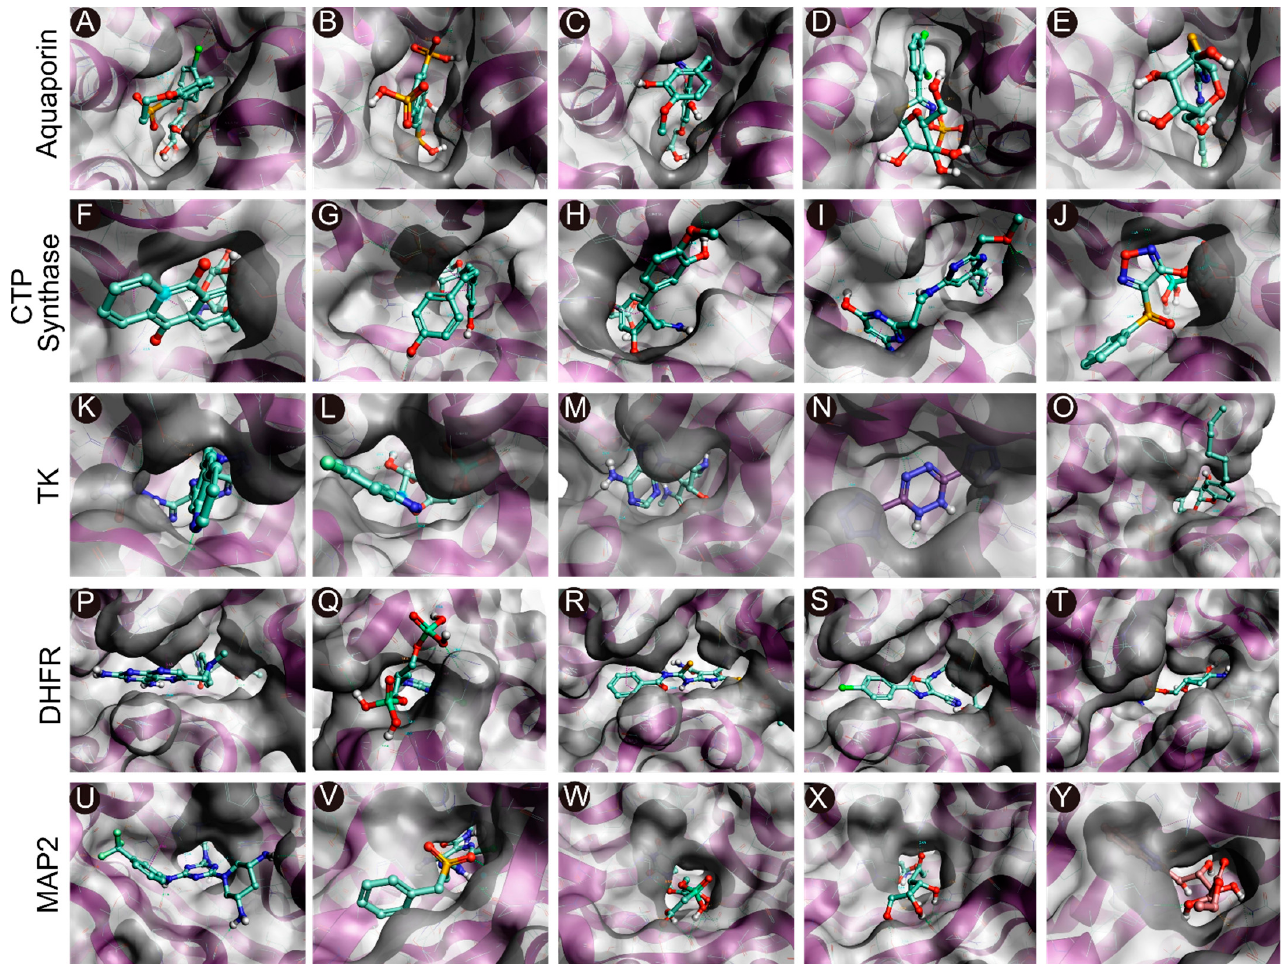
Figure 2. Molecular docking of the compounds to the predicted binding pockets of the five druggable protein targets of EHP. ( A – E ) Best binding poses of the five selected compounds atthe binding site of AQP (( A ): CHEMBL3703838; ( B ): ZINC000002243083; ( C ): CHEMBL133039; ( D ): CHEMBL3140193; and ( E ): CHEMBL2132563). ( F – J ) Best binding poses of the five selected compounds atthe binding site of CTP synthase (( F ): CHEMBL48494; G : CHEMBL1162979; ( H ): CHEMBL133039; ( I ): CHEMBL525202; and ( J ): CHEMBL1091856). ( K – O ) Best binding poses of the five selected compounds atthe binding site of TK (( K ): CHEMBL3674540; ( L ): CHEMBL1683320; ( M ): CHEMBL391279; ( N ): ZINC000031750813; and ( O ): CHEMBL4078273). ( P – T ) Best binding poses of the five selected compounds atthe binding site of DHFR (( P ): CHEMBL1966988; ( Q ): CHEMBL340488; ( R ): ZINC000016682862; ( S ): ZINC000828645375; and ( T ): CHEMBL3901573). ( U – Y ) Best binding poses of the five selected compounds at the binding site of MetAP2 (( U ): CHEMBL3913373; ( V ): CHEMBL1962731; ( W ): CHEMBL3142997; ( X ): ZINC000199197855; and ( Y ): ZINC000016682972).